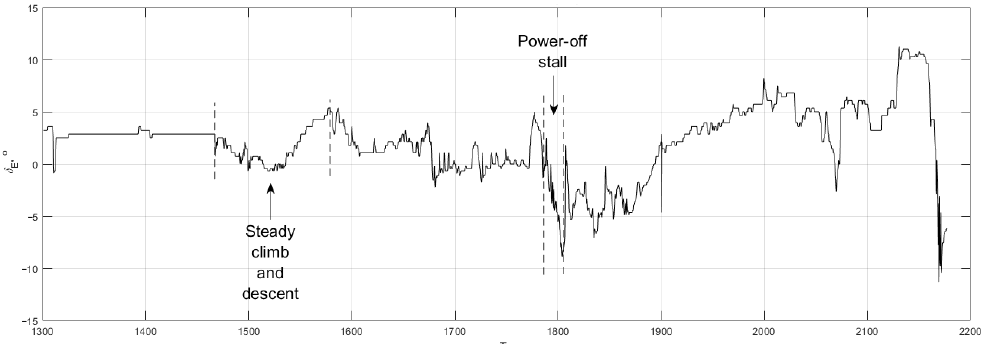
Figure 2. The elevator deflection angle during the test